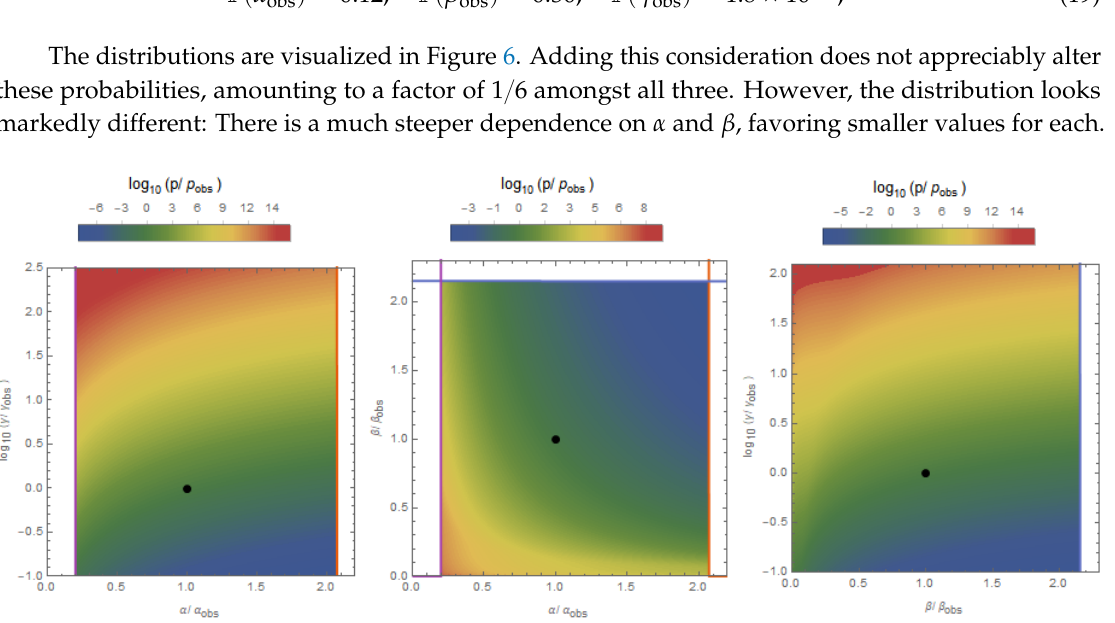
Figure 6. Distribution of observers from imposing the tidal locking